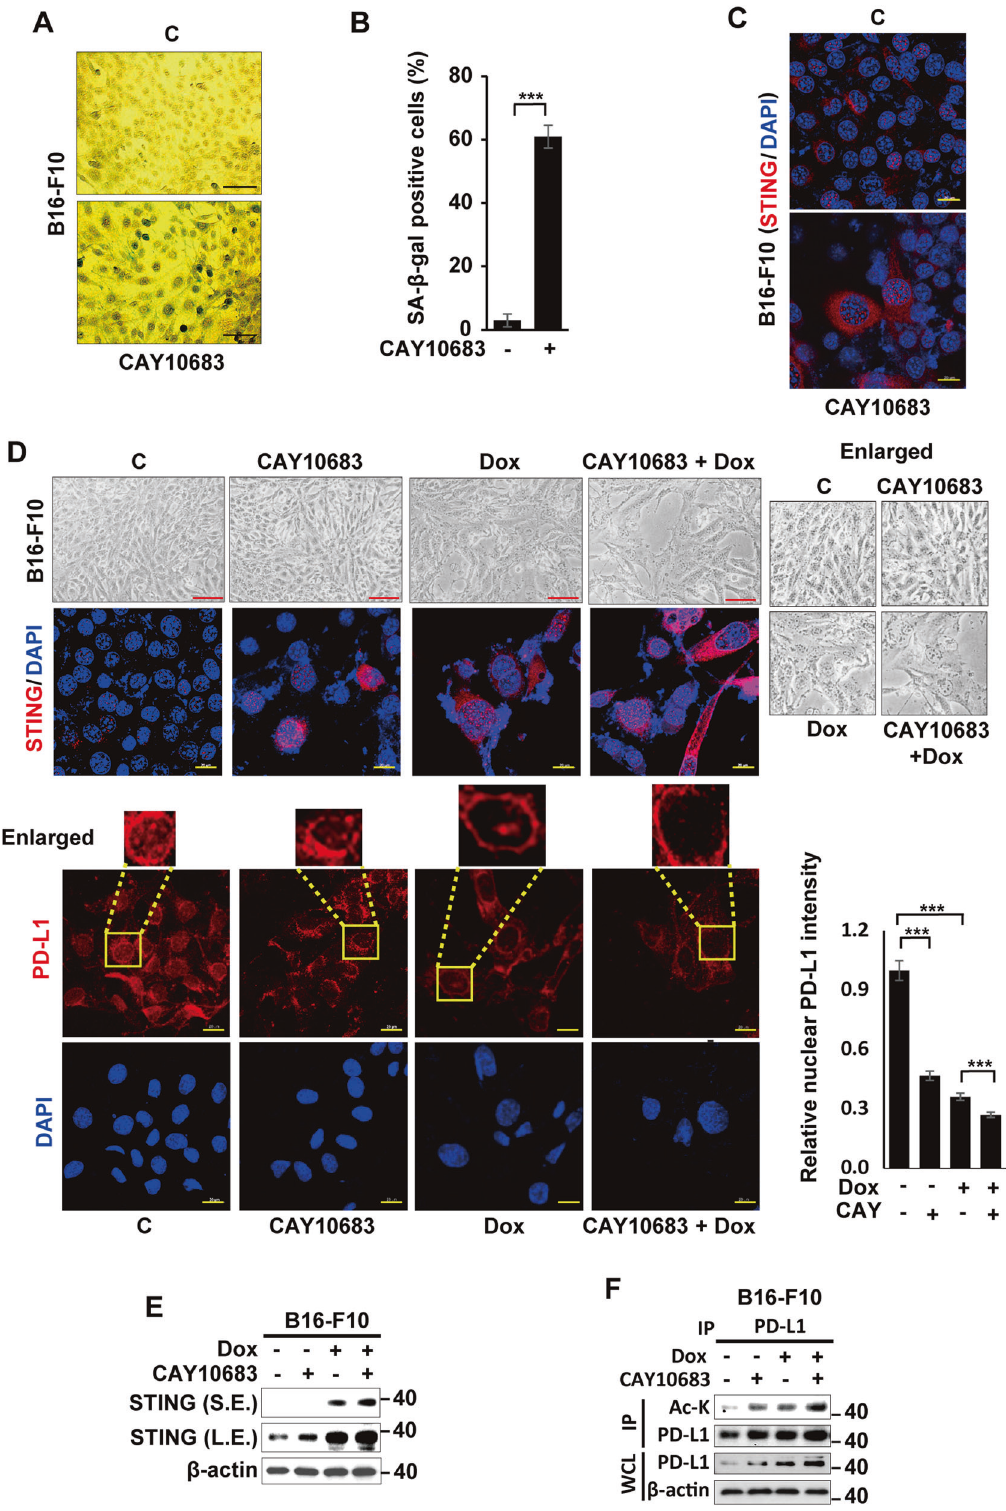
Fig. 4 Suppressing nuclear PD-L1 induces senescence via STING upregulation. B16-F10 cells were treated with pharmacological HDAC2 inhibitor (CAY10683). The SA- β -Gal-positive cells were photographed ( A ) and enumerated ( B ), and STING expression was analyzed by an immuno fl uorescence assay ( C ) on day 3 post-treatment. B16-F10 cells were treated with HDAC2 inhibitor 6 h prior to treatment with 100 ng/ mL Dox, and imaged on day 3 post-treatment; STING expression and PD-L1 localization were analyzed by an immuno fl uorescence assay. Relative nuclear PD-L1 intensity was analyzed using ImageJ ( n = 100) ( D ). Western blot analysis was performed ( E ) and PD-L1 acetylation was demonstrated using an anti-pan acetyl PD-L1 antibody on day 3 post-treatment ( F ). (S.E. short exposure, L.E. long exposure). Scale bars = 50 μ m ( A , D ; upper panel) and 20 μ m ( C , D ; lower panel). Statistical signi fi cance was determined by an unpaired, two-tailed Student ’ s t test with P < 0.05 ( B ) or one-way analysis of variance and Newman – Keuls ( D ). Quantitative data are expressed as the mean ± SD . *** p < 0.001. Cell Death and Disease (2022)